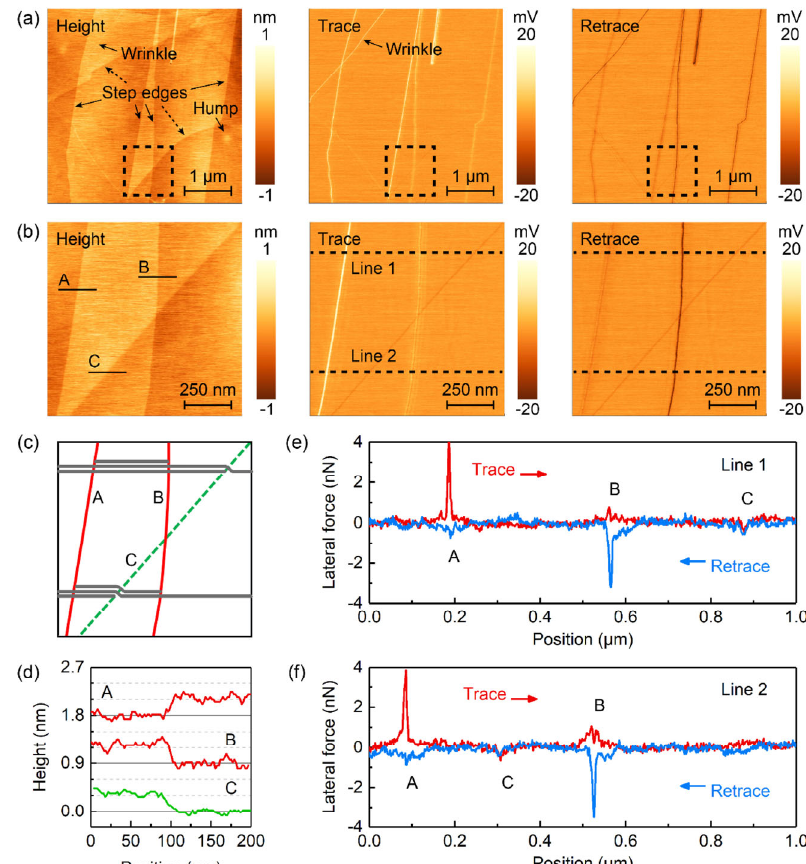
Fig. 1 Topography and lateral signal collected by AFM with contact mode on a graphite surface. (a) Height and lateral signal (trace and retrace) images of a 4 μ m  4 μ m area. (b) Height and lateral signal (trace and retrace) images of a 1 μ m  1 μ m area marked with a dashed box in (a). (c) Illustration showing step edges identified in (b), with the red lines indicating exposed step edges and the green line indicating the buried step edge. (d) Height line profiles along the solid-lines across the three steps marked as A, B, and C in (b). (e, f) Lateral signal line profiles marked with dash-lines (Line 1 and Line 2) in